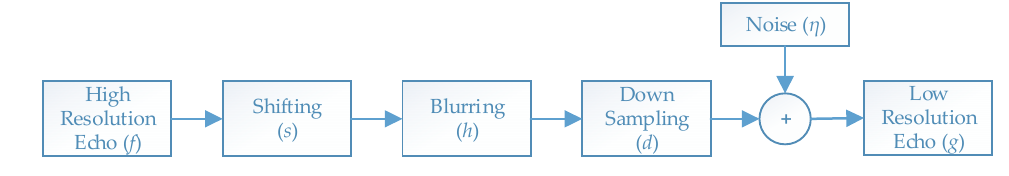
Figure 1. Low-resolution imaging model of weather radar echo.